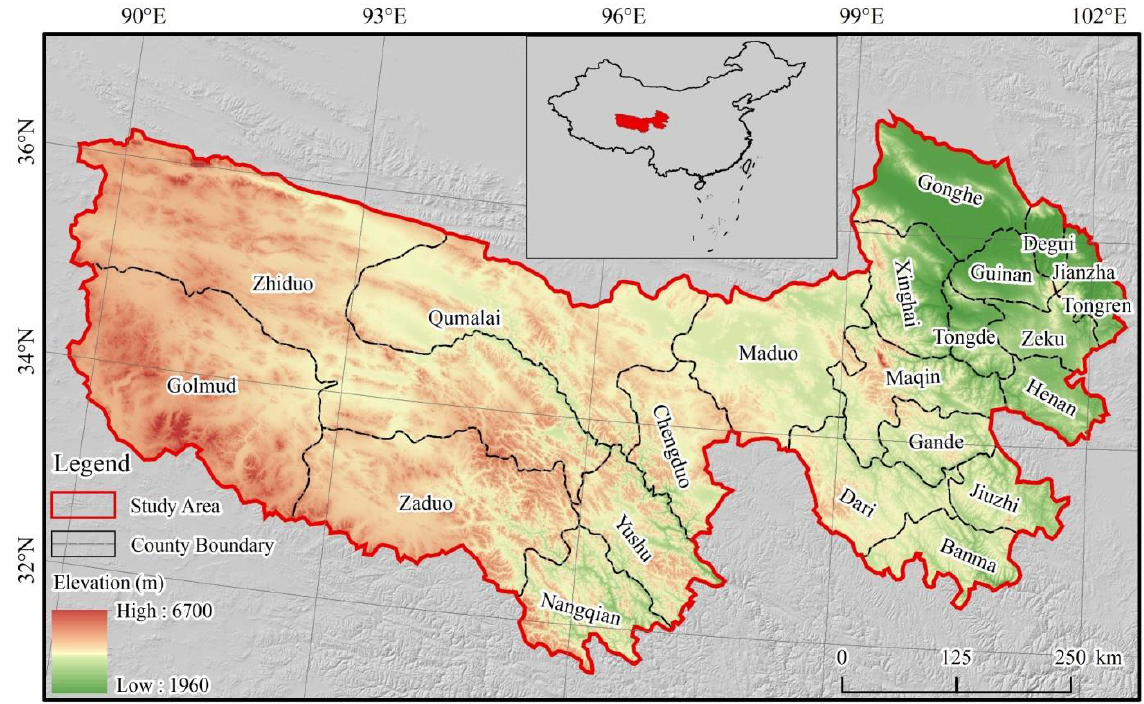
Figure 1. Geographical Location of the study area.